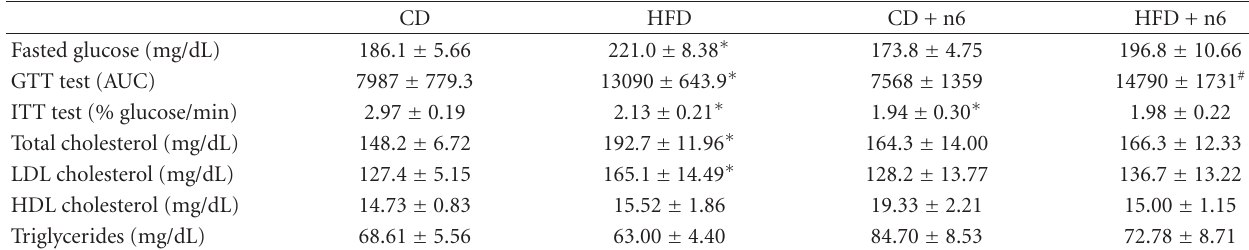
Table 2: Metabolic parameters from mice fed with control diet (CD) or high-fat diet (HFD), supplemented, or not with sunflower oil (rich in n-6 fatty acids).